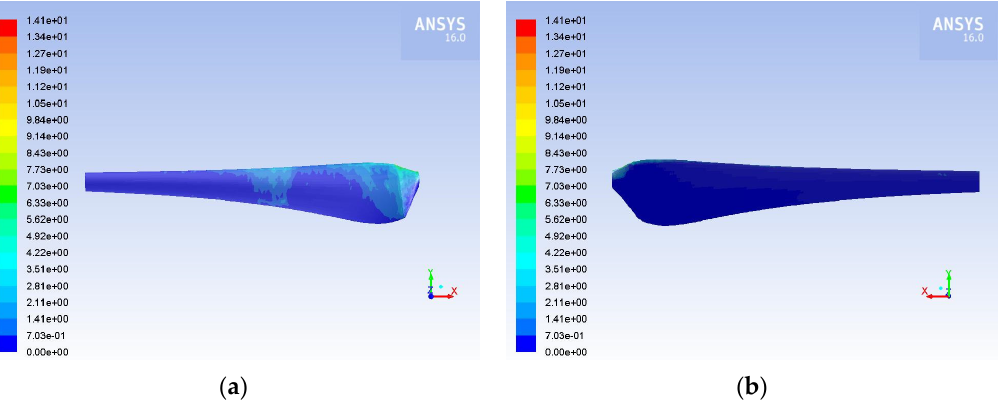
Figure 13. Concentration of particles on ( a ) the pressure; ( b ) the suction side of the blade for hailstorm conditions and air velocity equal to 10 m·s − 1 .